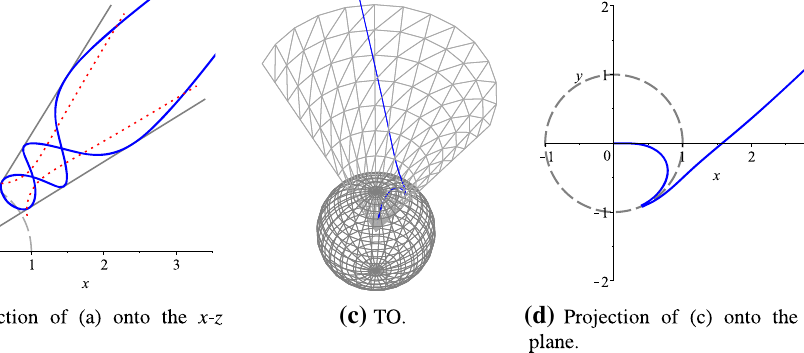
Fig. 10 a , b TEO for parameters K = 4 , L = 4 , δ = 0 , l = 1 , J = 0, and energy E = 0 . 4. In b the dotted curve denotes the turning points of the φ motion. c , d TO for parameters K = 0 , L = 8 , δ = − 1 , l = 1 , J = 4, and energy E = Ll = 8. The trajectory lies on a cone with